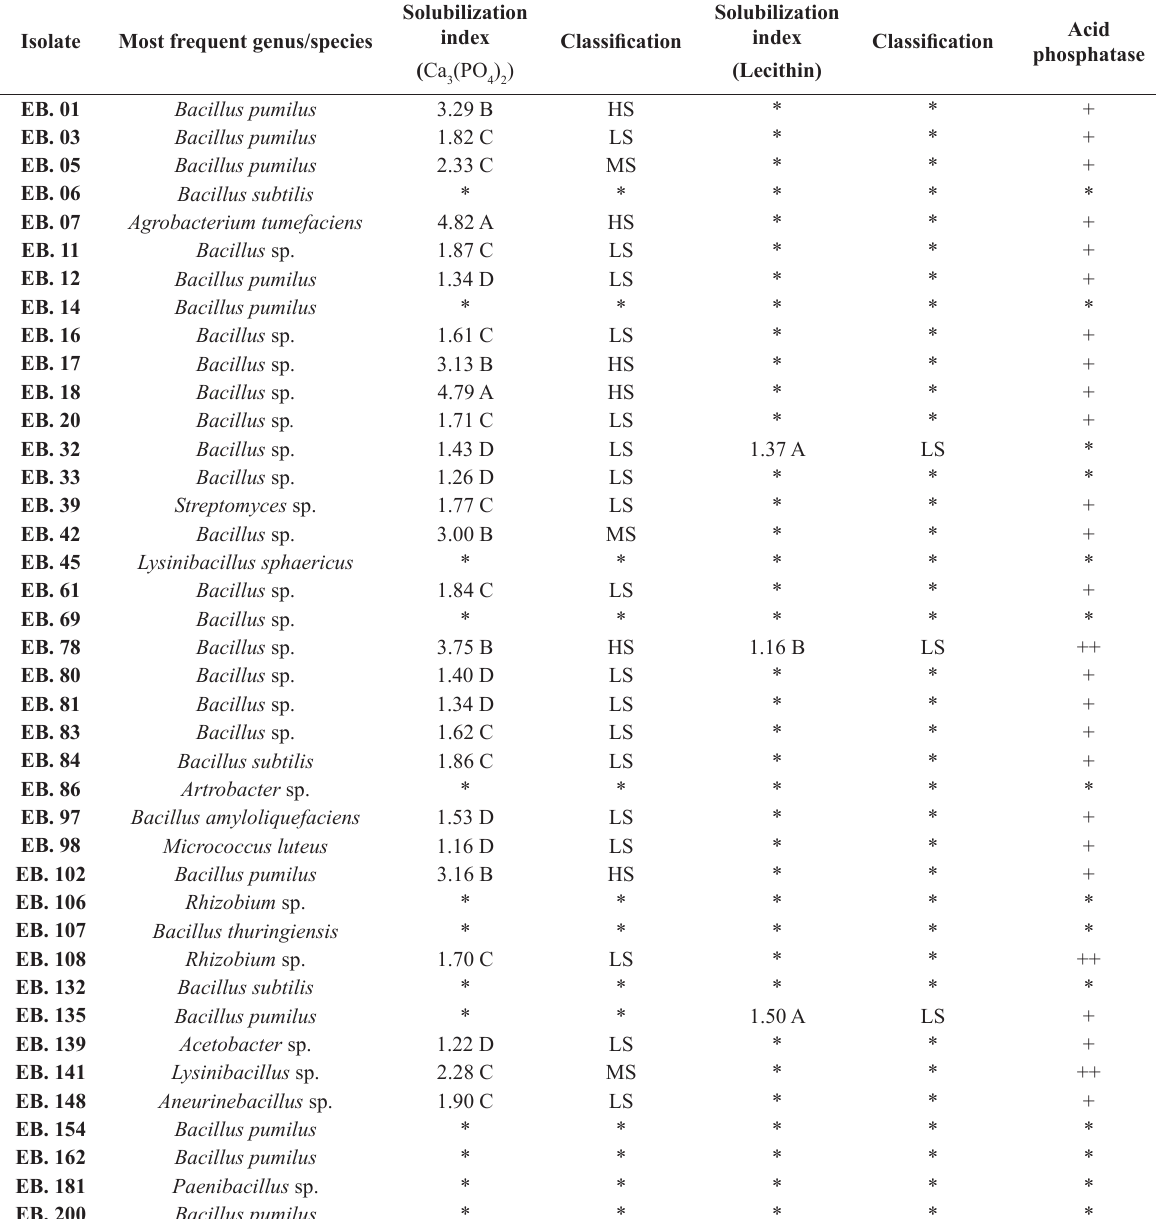
*Indicates isolates with negative results. The means followed by the same upper case letters indicate they belong to the same group through the Scott-Knott test at a significance level at P <